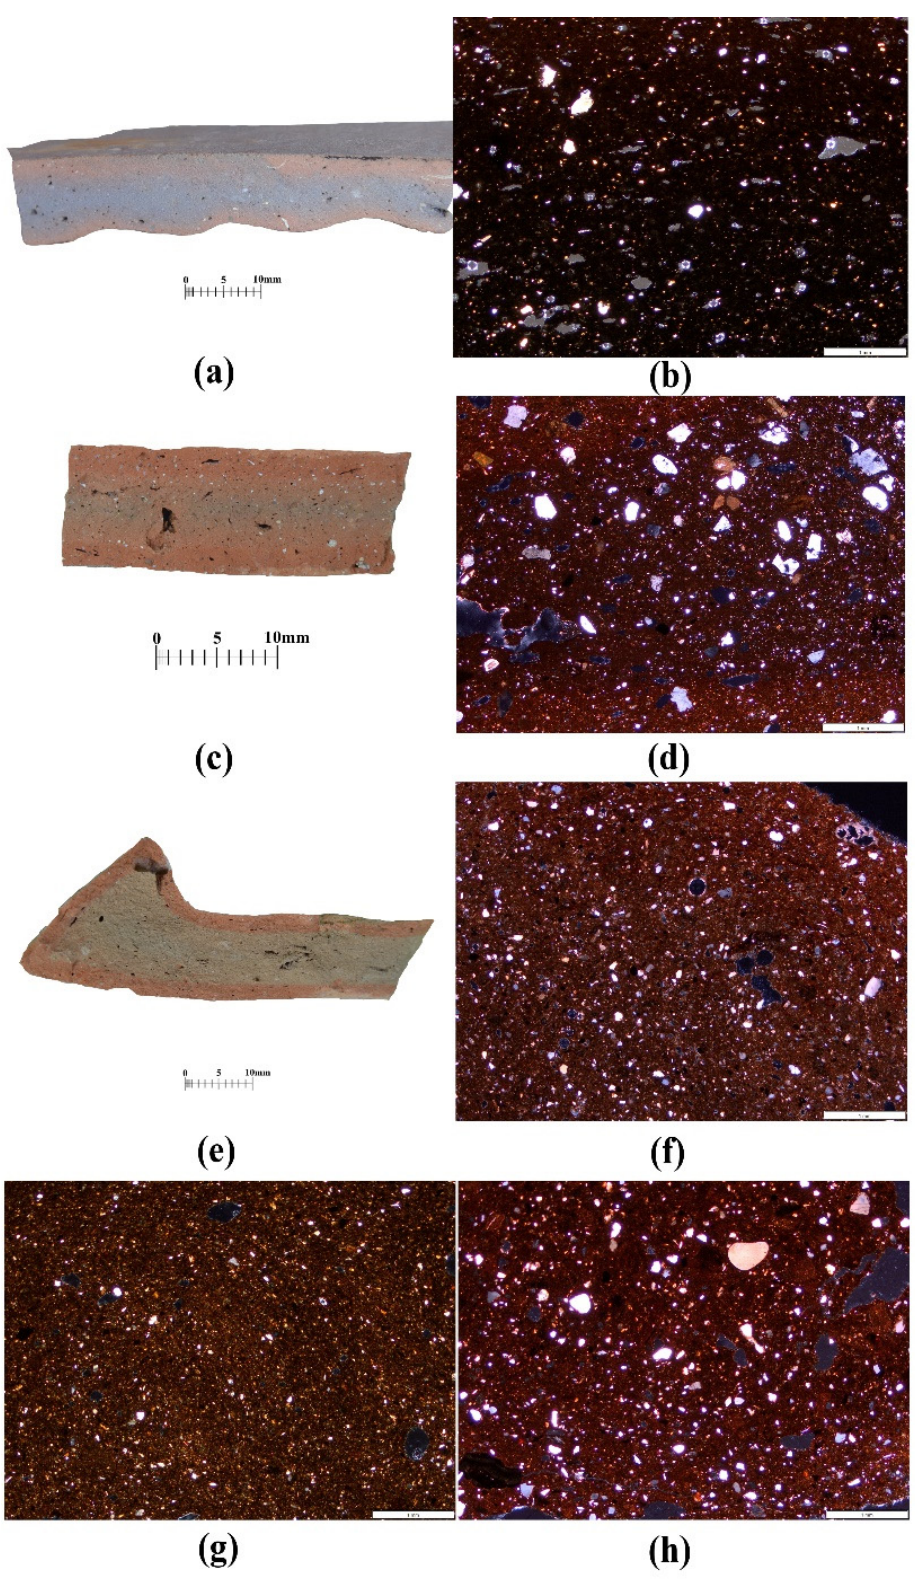
Figure 8. Fabric PHIM01a: macrophotograph ( a ) and photomicrograph in XP ( b ) of individual HIM178; fabric PHIM01b: macrophotograph ( c ) and photomicrograph in XP ( d ) of individual HIM078; fabric PPAR01: macrophotograph ( e ) and photomicrograph in XP ( f ) of individual PAR002; photomicrograph of DHIM01 ( g ) and DPAR01 ( h ) fired at 850 °C.